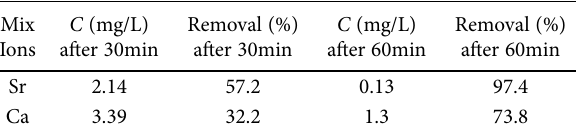
Table 2. Batch ion flotation results using air bubbles for 100mL solutions of 5mg/L calcium and strontium mixtures, using N-octanoyl-cys surfactant at an initial concentration, C surfactant =0.01M and